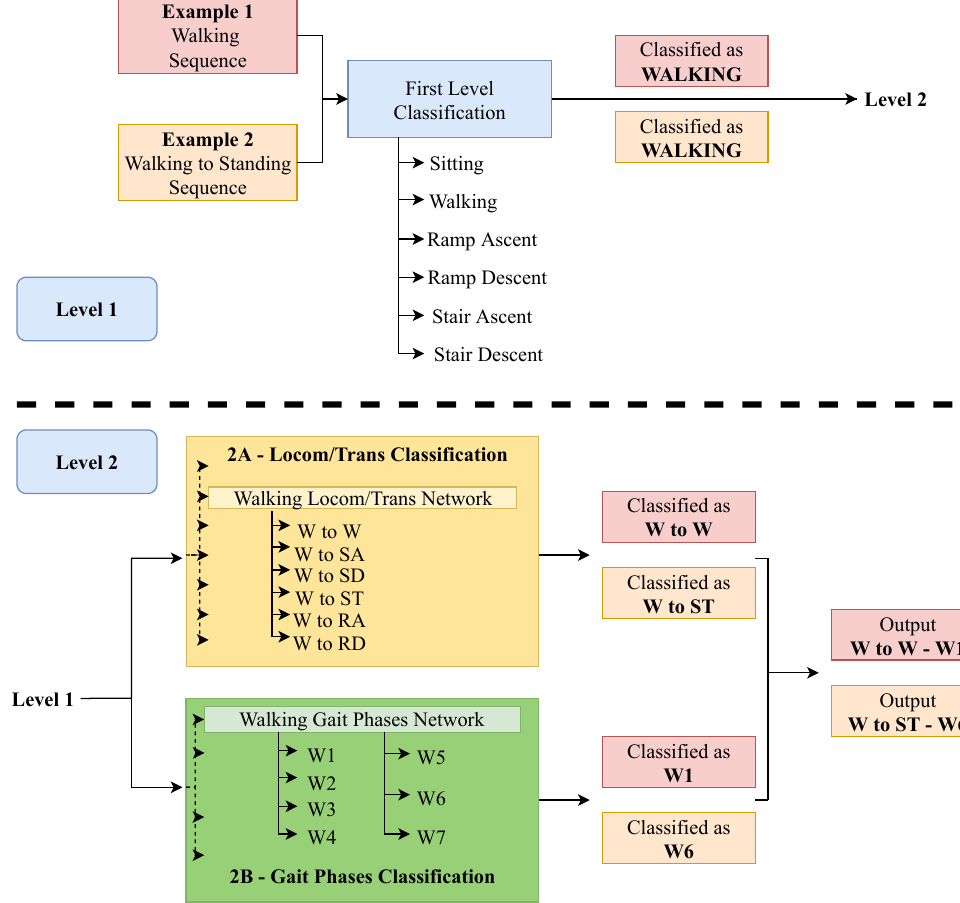
Figure 5. Example of classification of a given